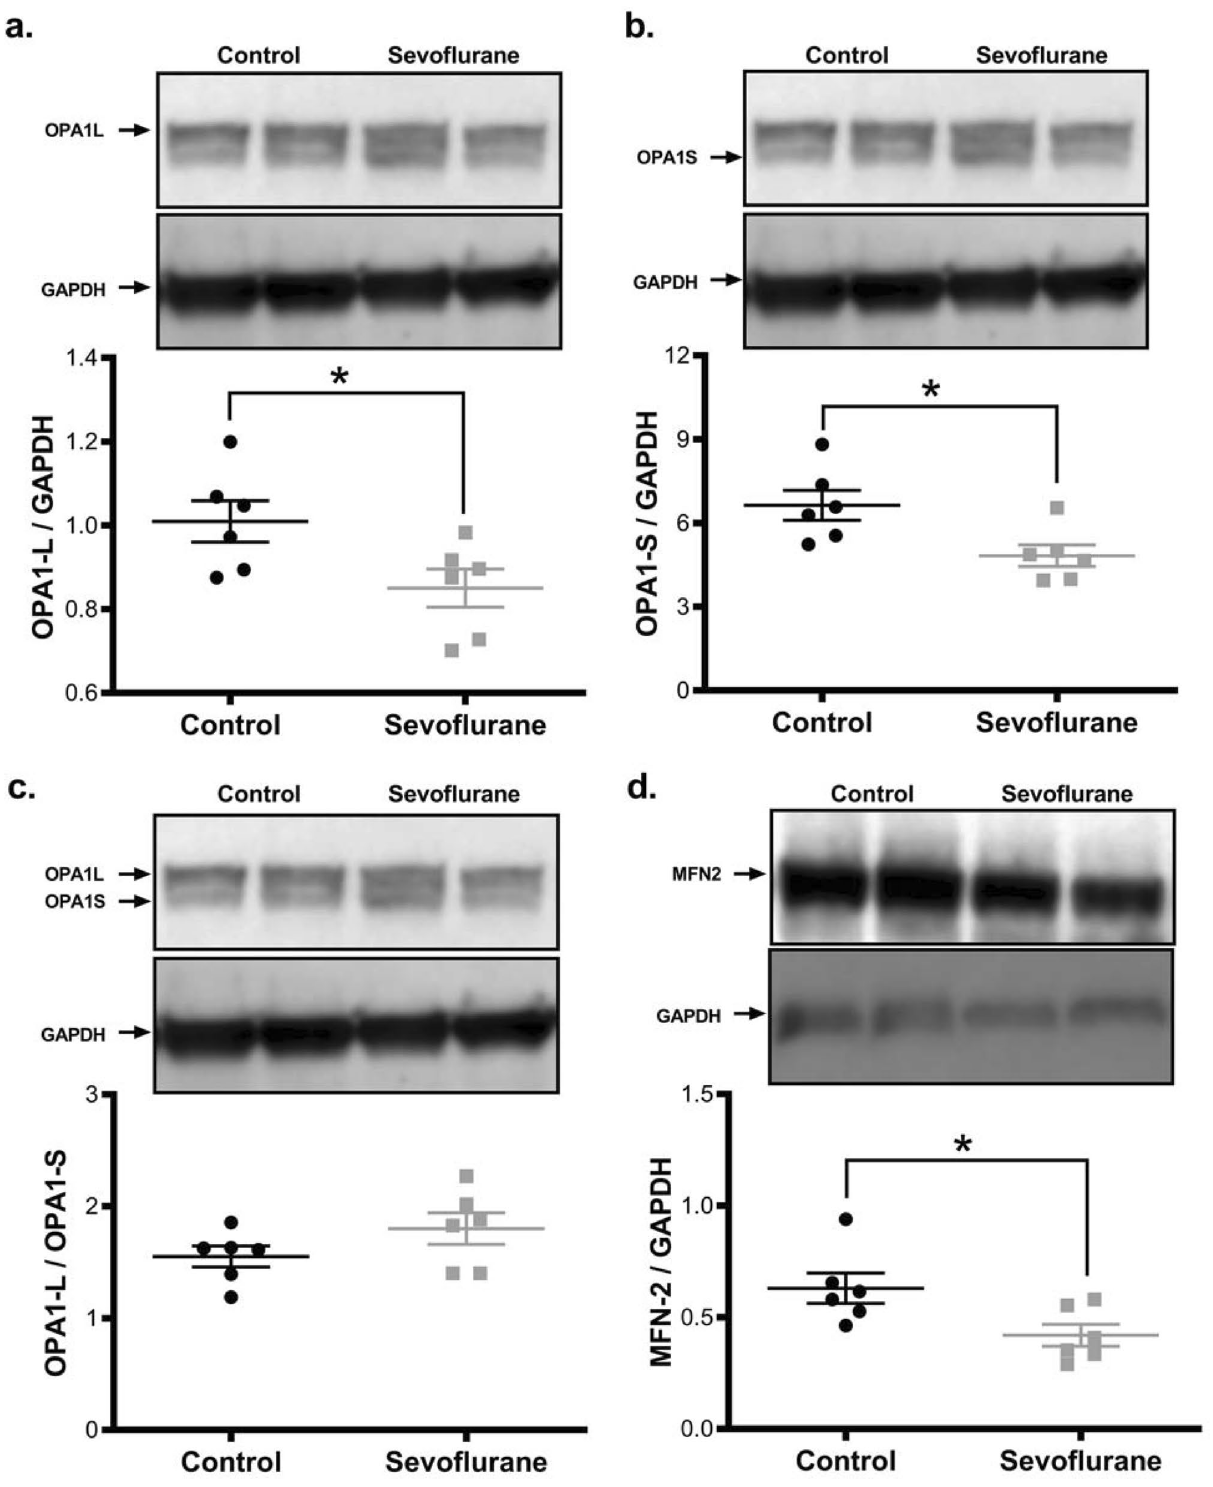
Figure 3. Protein mediators of mitochondrial fusion are reduced following P7 sevoflurane exposure. Pro-fusion proteins essential for inner- (OPA1 ( a – c )), and outer- (MFN-2 ( d )) mitochondrial membrane association are reduced in sevoflurane exposed tissue. While both the long and short forms of OPA1 were reduced, the ratio of long:short was increased, indicating an alteration to fusion activation. Values represent means ± SEM, with 6 animals in each group. Statistical significance between groups indicated with (*) for p -value < 0.05. All samples derived from same experiment and gels/blots processed in